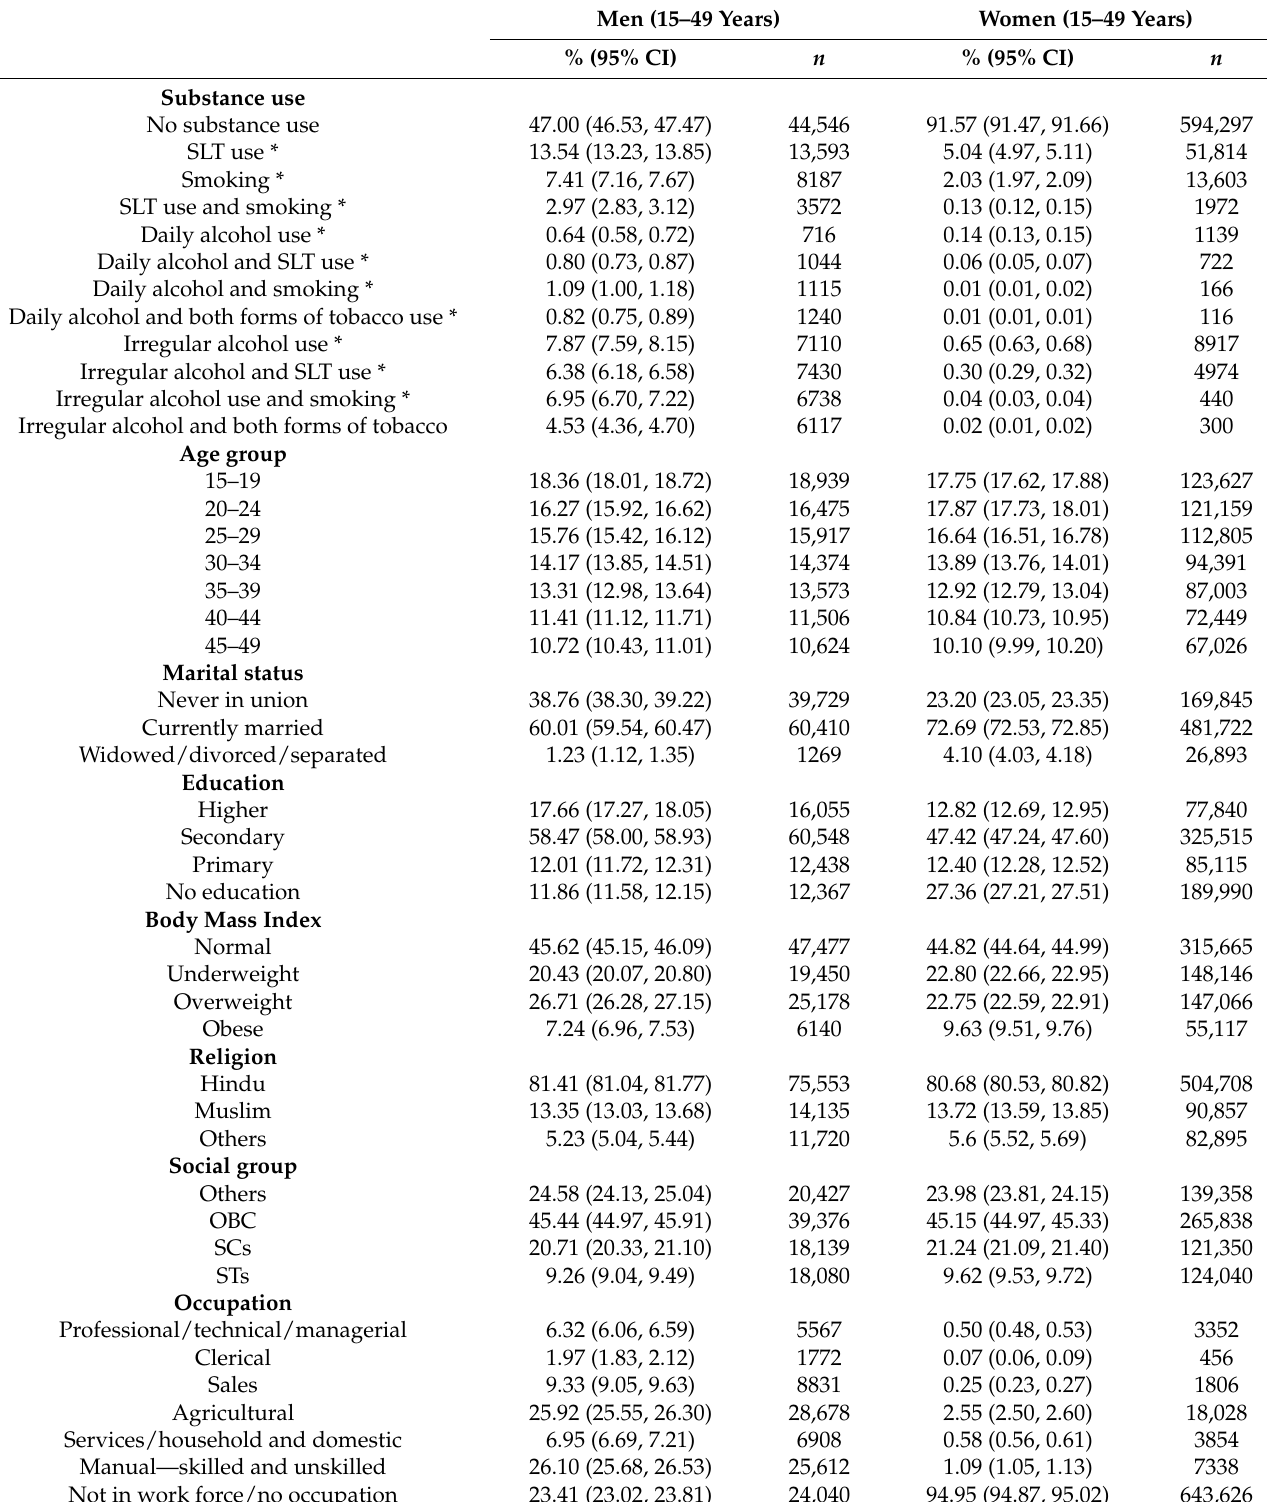
Table 1. Sample distribution of men and women aged 15–49 years by key predictor and select correlates, India,